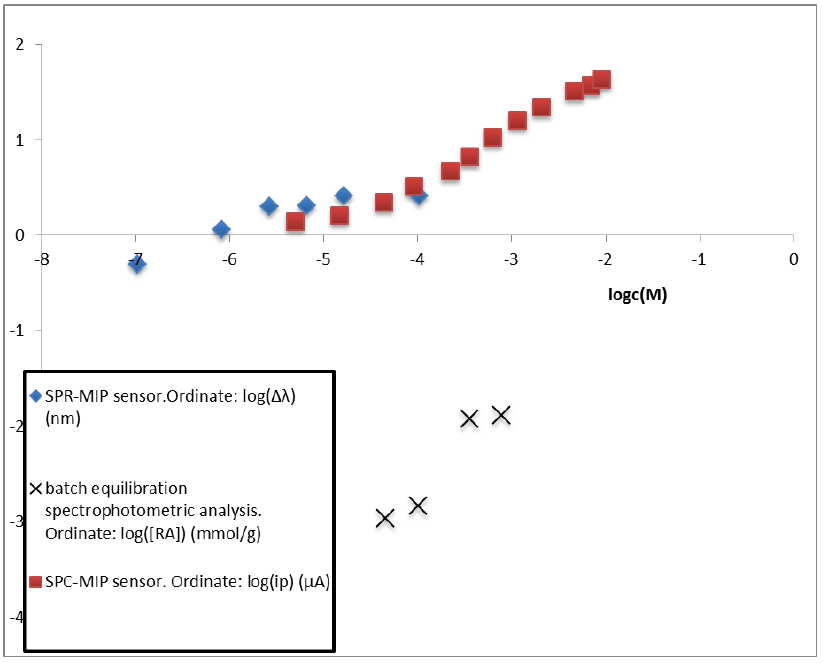
Figure 10. Adsorption isotherms obtained by different methods: optical SPR-MIP sensor, electrochemical SPC-MIP sensor and by batch equilibration and spectrophotometric analysis.